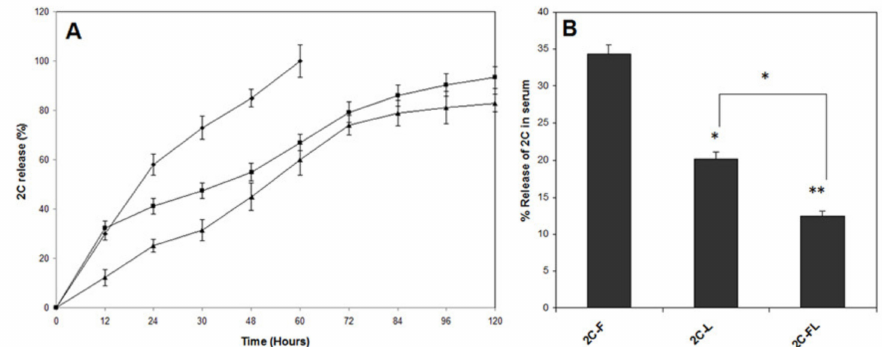
Figure 2. Cumulative in vitro release of 2C from different types of formulations. ( A ) Profile showing the kinetic release of 2C from the different formulations viz. , 2C-F, 2C-L and 2C-FL. ( B ) Profile showing the release of 2C from the different formulations viz. , 2C-F, 2C-L and 2C-FL into the serum after 24 h. Data are presented as the mean ± standard deviation (SD) of three independent experiments. * p < 0.01; ** p <